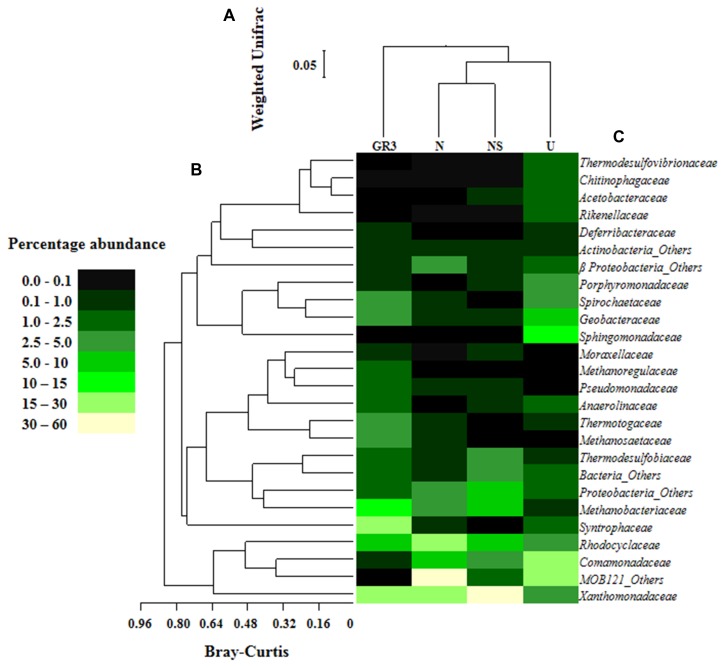
Relative abundance of major families detected in original and microcosm samples and their interrelations. Heat map showing relative abundance of major bacterial and archaeal families detected in the four metagenomic libraries (A). Families which gave cumulative relative abundance of >1% have only been considered. Bray–Kurtis relationship (B) among the abundance of families across the samples and Weighted UniFrac relationship (C) between the samples, based on the composition as represented by the major taxa were also presented. Change in the percent abundance of major taxa at lowest level of identification was presented (D). For determining the change abundance of any specific taxa in microcosm sample was subtracted from the same in GR3.